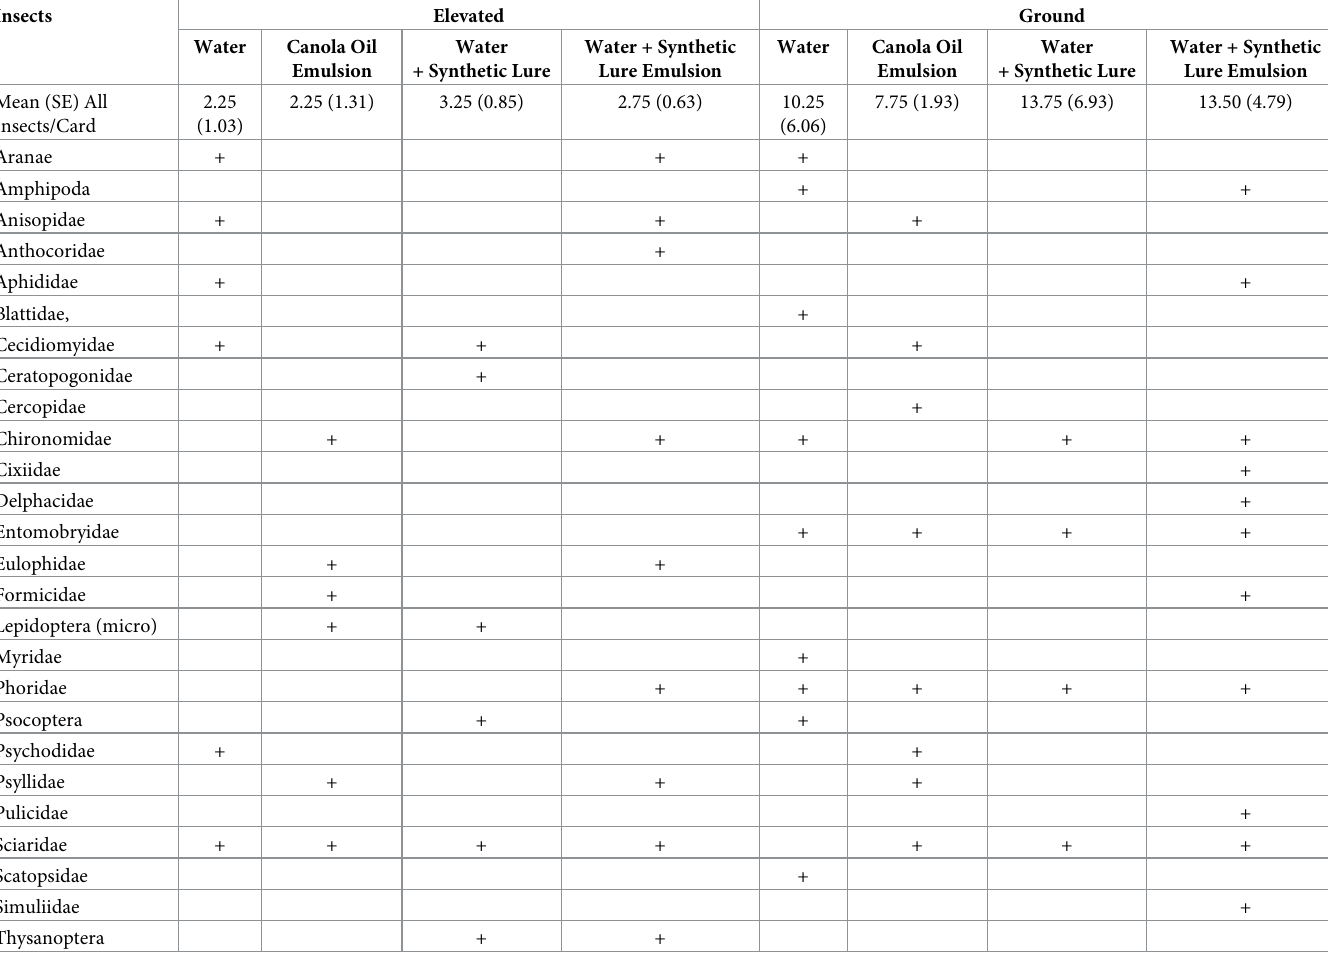
Table 5. The pooled mean numbers (SE) and types of insects captured (indicated by ‘+’) on sticky cards (n = 8) baited with cotton wicks saturated with water, canola oil emulsion, synthetic papaya oil lure (0.2%) in water or synthetic papaya oil lure (0.2%) in a canola oil emulsion collected over 24 h in Hilo, HI, USA. Sticky card were suspended 1m (elevated) or placed on the ground (ground). Emulsions were 1:1:0.2 water/oil/ Tween 1